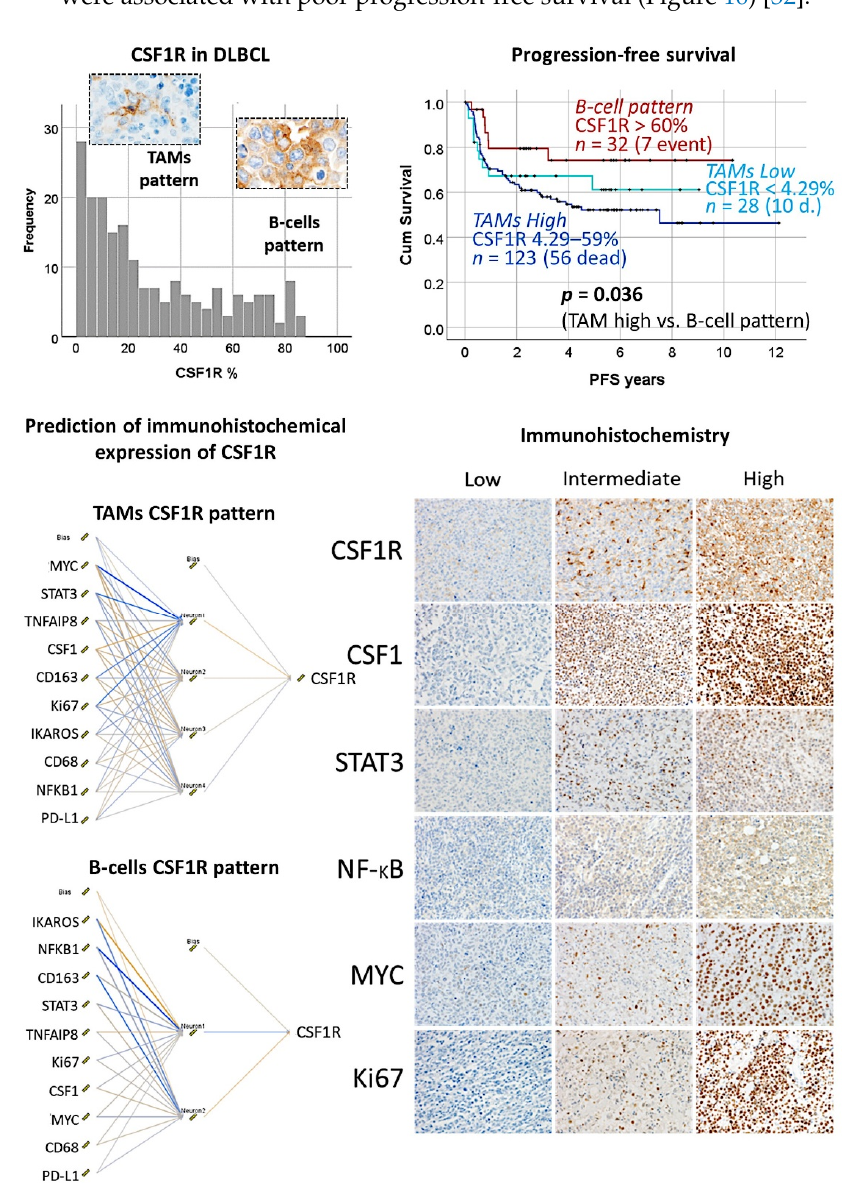
Figure 16. Role of CSF1R in the prognosis of diffuse large B-cell lymphoma. CSF1R was analyzed by immunohistochemistry in a series of 198 cases, and two histological patterns were found. A CSF1R- positive B-cell pattern was characterized by favorable progression-free survival; this pattern was less frequent (around 30% of the cases). Conversely, the most frequent pattern was of CSF1R- positive tumor-associated macrophages (TAMs) and was associated with an unfavorable outcome. Additionally, the prediction of the immunohistochemical expression of CSF1R by other CSF1R-related markers was performed using neural networks. The CSF1R-related markers were CSF1, STAT3, NFKB, MYC, and Ki67. All markers were quantified using digital image analysis. Of note, the multilayer perceptron network analyses were performed to predict both the TAM and the B-cell patterns. Our data suggested that the use of a CSF1R inhibitor such as Pexidartinib could be used in the CSF1R + TAM pattern. CSF1R, macrophage colony-stimulating factor 1 receptor; DLBCL, diffuse large B-cell lymphoma; TAM, tumor-associated macrophage, PFS, progression-free